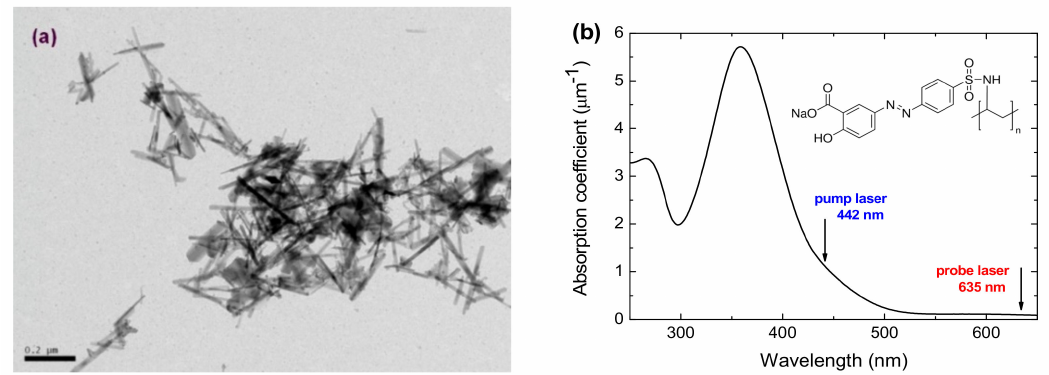
Figure 2. ( a ) TEM image of the goethite ( α -FeOOH) nanorods; ( b ) absorption coefficient spectrum and chemical structure of the azopolymer